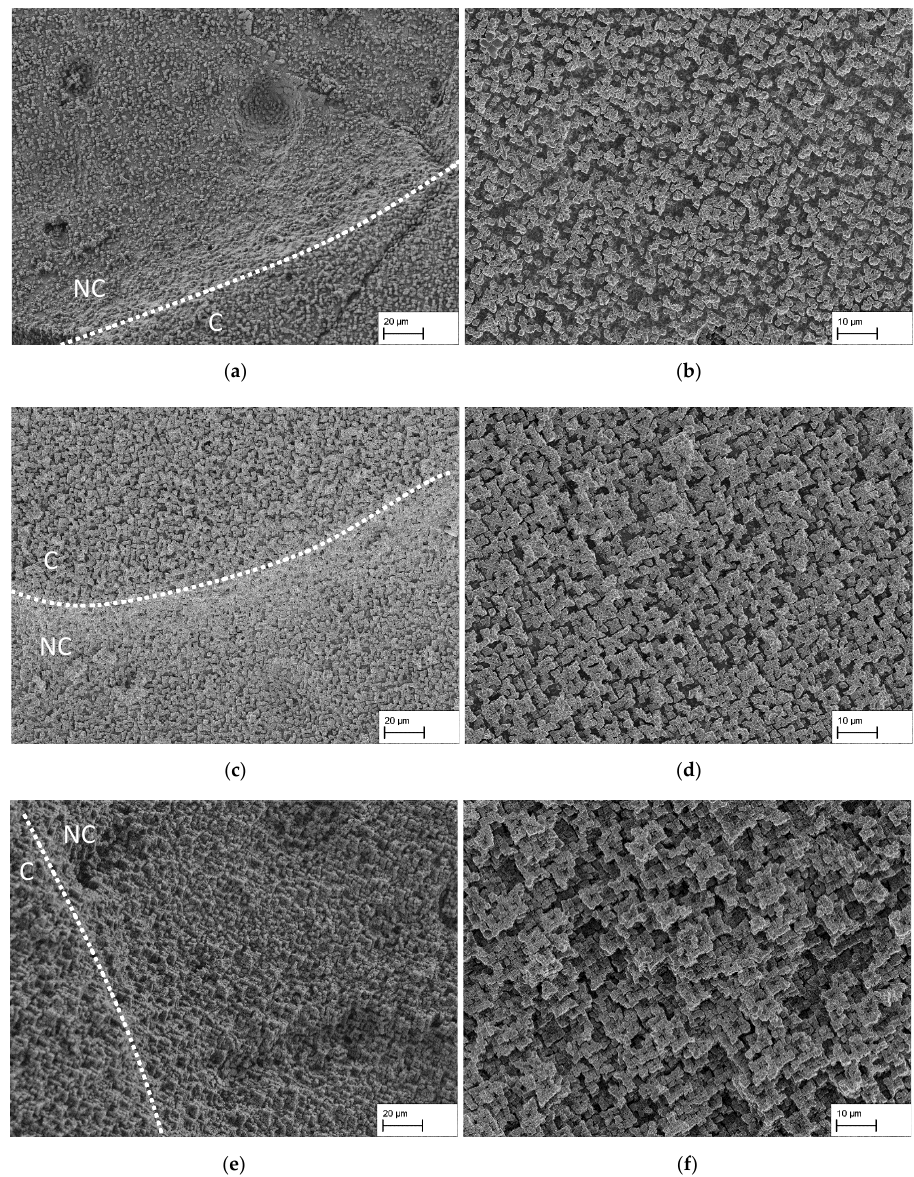
Figure 7. Surfaces of the deeply etched specimen. In each case, the transition between coated (C) and not coated area (NC) is marked by a dotted line. Here a recess of the deeply etched area is visible, which shows that a complete connection of the γ ’-particles to a continuous network is not established. On the right-hand side, an image of the not coated area is shown at higher magnifications, showing γ ’-particles either protruding further from the surface if they are connected or as long as they remain as individual ones causing less rough surfaces; ( a ) 1025 ◦ C—uniform roughness; ( b ) 1025 ◦ C— individual precipitates which are connected to the deep lying matrix that has not yet been extracted; ( c , d ) 975 ◦ C—visible further protruding precipitates, due to cross-linking. ( e ) Surface roughness at the transition area in the specimen cooled to 900 ◦ C; ( f ) 900 ◦ C—several layers of precipitates cross-linked with each other and protruding far from the “extraction plane” (i.e., up to which the matrix was